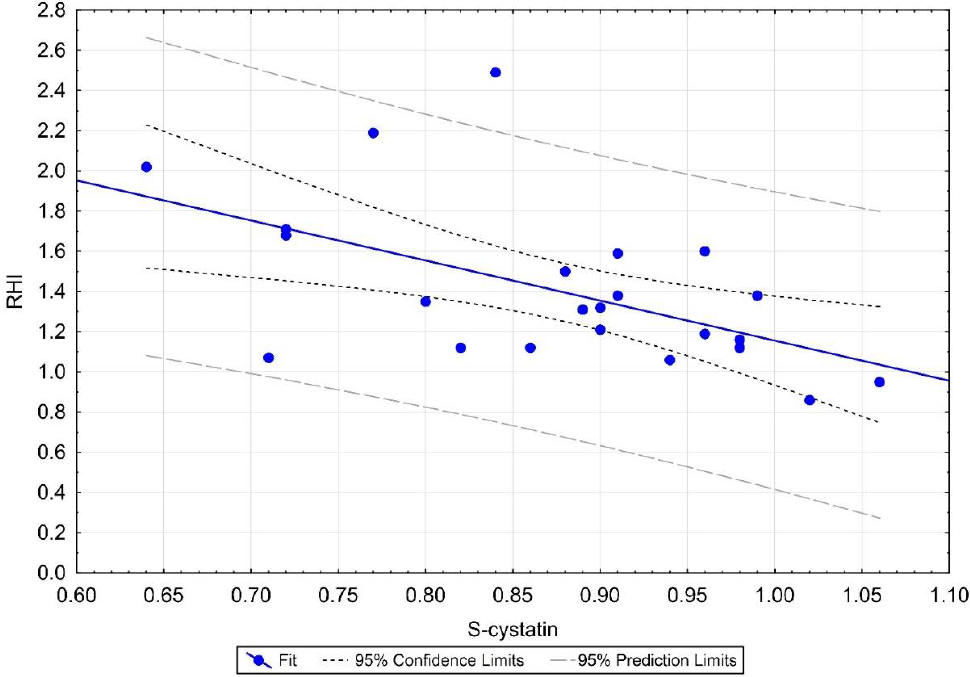
Figure 4. Linear regression of RHI and S-cystatin C in MIS-C. Moderately strong, negative correlation confirmed. MIS-C: multisystem inflammatory syndrome in children; RHI: reactive hyperemic index.